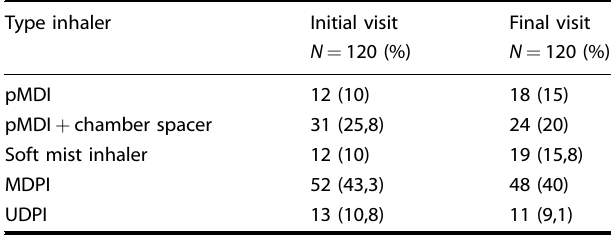
Table 2. Types of inhalers evaluated in the study visits. Type inhaler